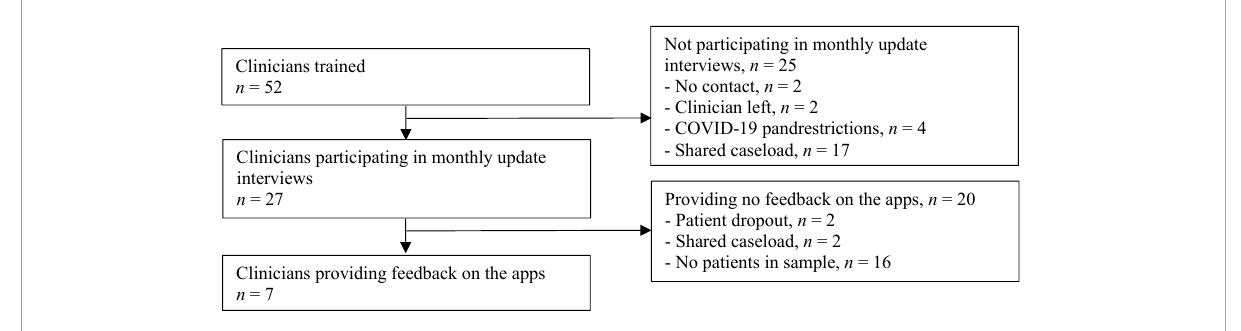
FIGURE1 Clinicians’ enrolment flow. “Shared caseload” means that all clinicians on the team were involved in treating all patients. One clinician per team was chosen to represent the team in the